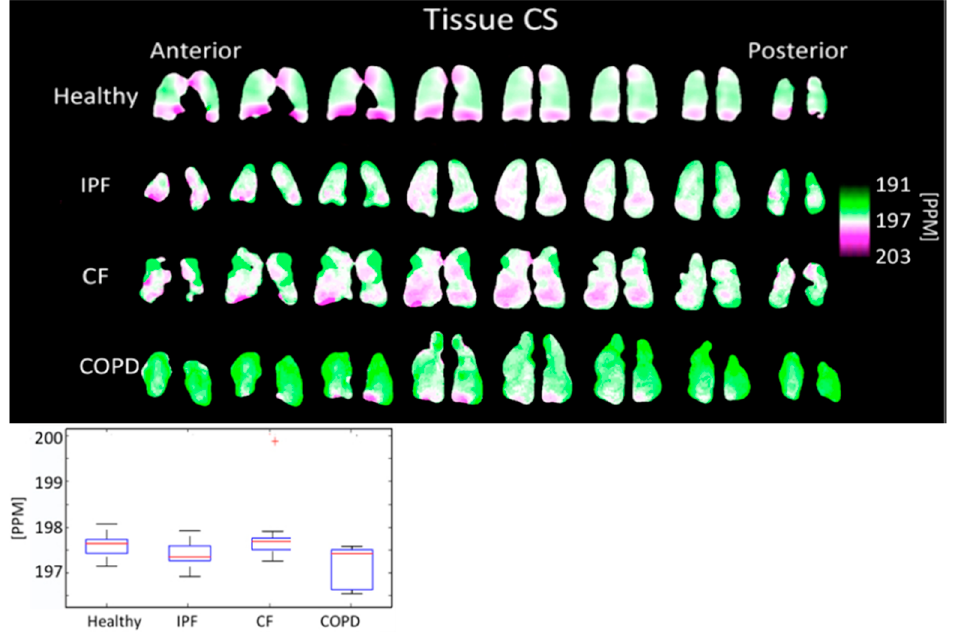
Figure 8. Tissue chemical shift maps ( top ) and boxplots ( bottom ) for each disease type. The color bar corresponds to the location of the geometric center of the tissue peak. Results are not significantly different. ( + outlier) .